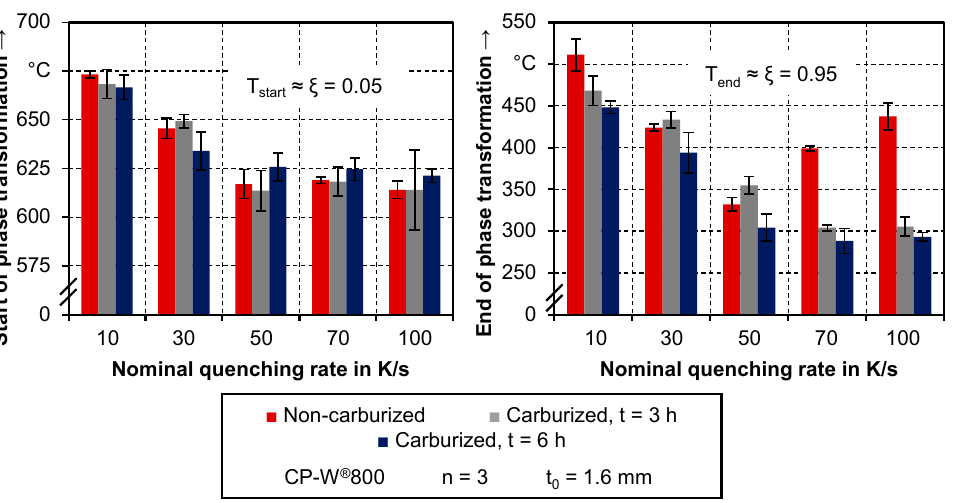
Figure 6. ( a ) Start and ( b ) end temperature of the austenite decomposition.